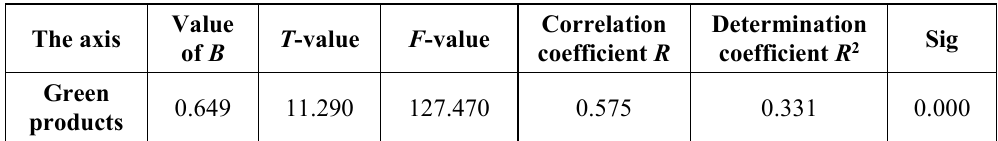
Table 5. Result of Simple Regression Analysis to Test the Impact of Green Products on Customer Loyalty Determination Correlation Value F -value T -value The coefficient R 2 coefficient R of B